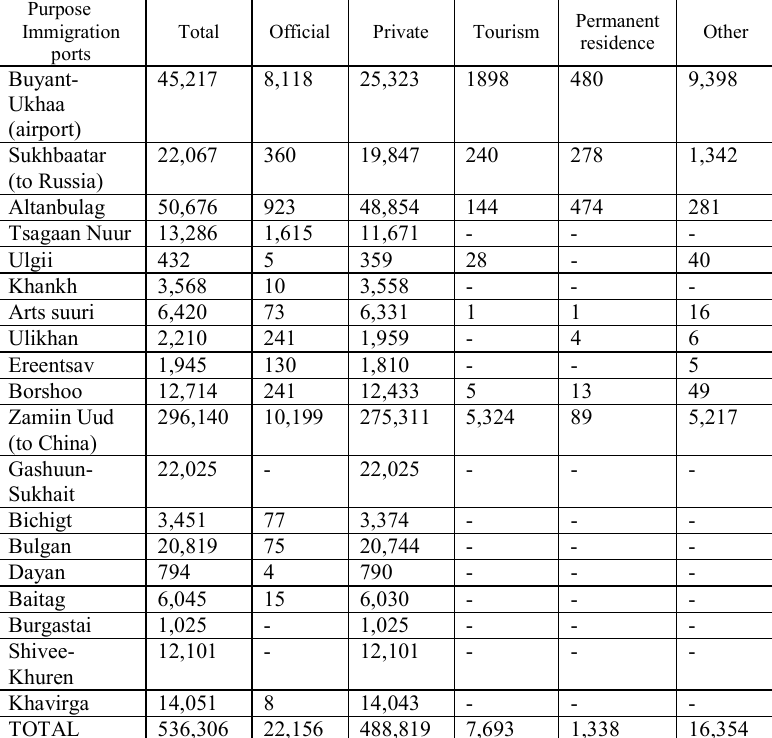
Table 4: Outbound Mongolian Passengers by Port and Purpose, 2002